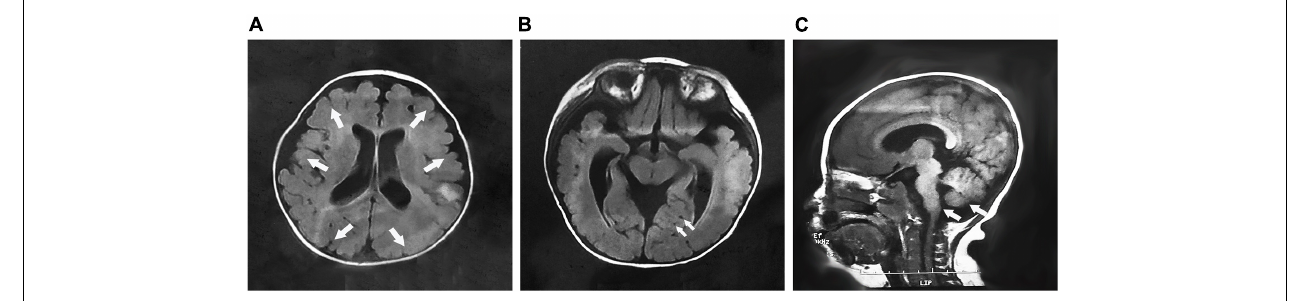
FIGURE 1 | The brain MRI of patient 10 at 7 months of age. (A) Cross-sectional imaging showed polymicrogyria in the frontal, temporal, parietal, and occipital regions (arrows); (B) multiple cysts were identified in the cerebellum (arrows); and (C) sagittal imaging showed the cerebellum and brainstem dysplasia (arrows).